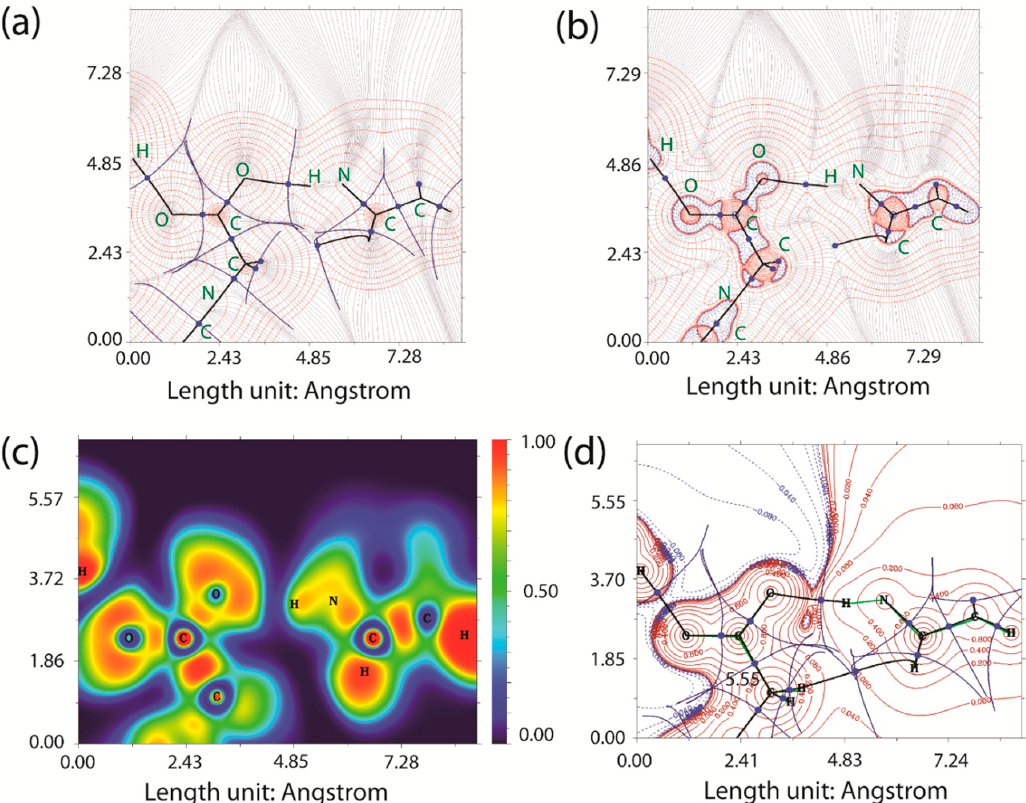
Figure 8. QTAIM analysis of charge-assisted hydrogen-bonding interactions in IM + –NPG − –HYD (for configuration A ). ( a ) Contour-line plots of the electron density ρ . ( b ) Contour-line plots of the Laplacian distribution of electron density ∇ 2 ρ (r), where the solid (red) and dashed (blue) lines correspond to the positive and negative values of ∇ 2 ρ (r), respectively. ( c ) Surface maps of ELF. ( d ) Counter-line map of the electrostatic surface potential (ESP), where the solid (red) and dashed (blue) lines correspond to the positive and negative values of ESP, respectively. BPs are shown as black lines, the selected zero-flux surfaces, or interbasin paths as blue lines, and BCPs (3, –1) are shown in blue.